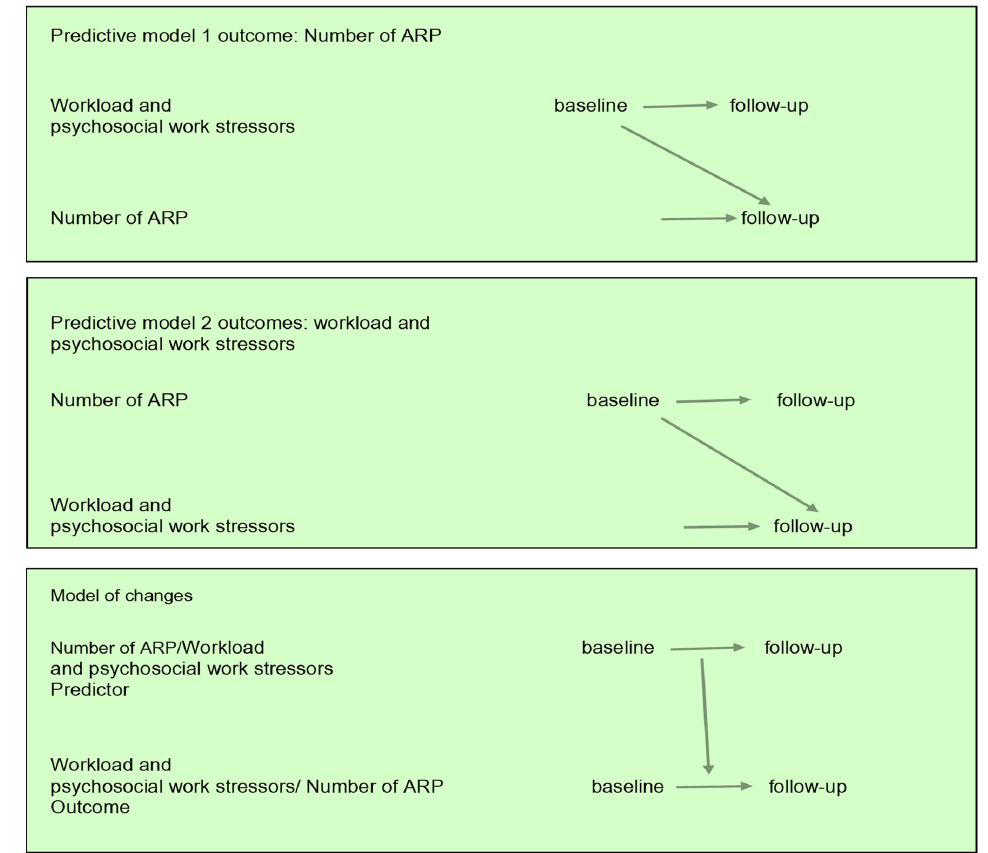
Figure 2. Graphic depiction of the models used to examine the longitudinal association between the number of anatomical pain regions, workload, and psychosocial work stressors. ARP = anatomical regions with pain.